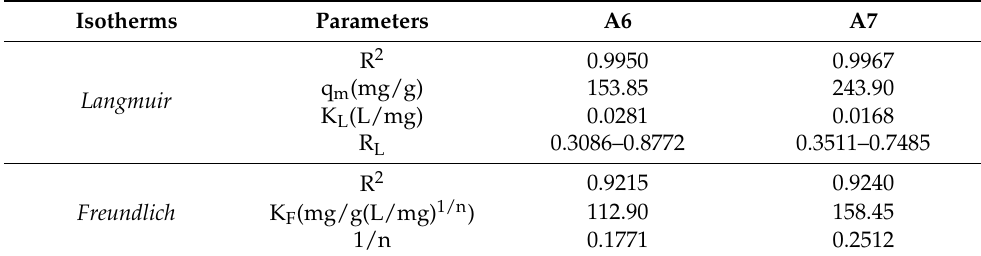
Table 5. Parameters of linear form Langmuir’s and Freundlich’s equations.